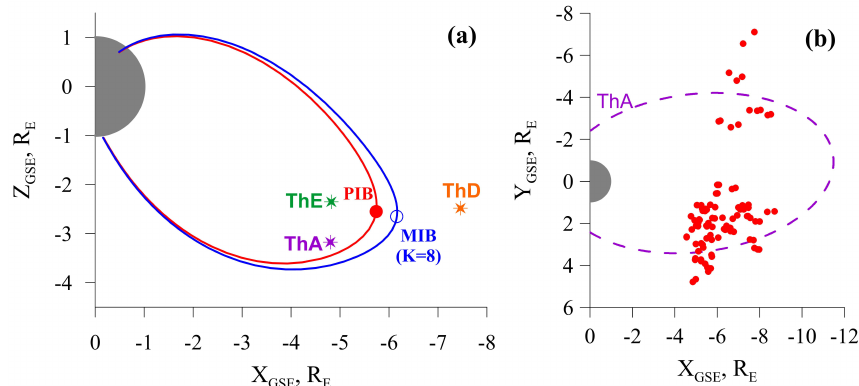
Figure 2. Panel (a) : XZ projections of the magnetic field line starting from the observed isotropy boundary (red; labeled PIB) and of the field line crossing the critical equatorial point (where K = 8; blue; labeled MIB), together with locations of three THEMIS spacecraft. Panel (b) : equatorial mapping of sample ThA trajectory on 4 March 2009 (dashed line) and the locations of projected isotropy boundaries (PIBs) in the final selected conjunction events.